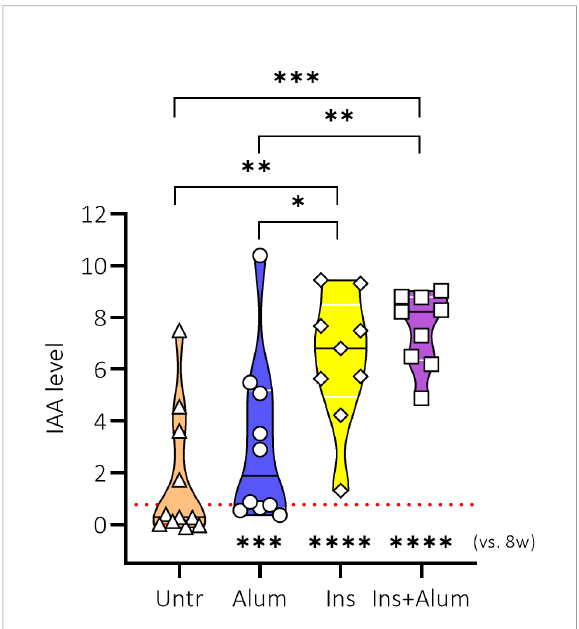
FIGURE 2 Effect of therapy on insulin autoantibody concentrations. IAA concentrations in plasma are shown at 15 weeks of age in female NOD mice receiving four weekly subcutaneous injections, from 10 until 13 weeks of age, of InsB:8-24 peptide formulated in alum (Ins+alum), InsB:8-24 peptide dissolved in buffer (Ins), alum alone (alum), or left untreated (Untr). The mean IAA value at 8 weeks of age (baseline) in all mice (n = 40) was 0.7627, represented by a dotted red line. Statistics underlying the violin plots represents comparison between baseline measurement at 8 weeks of age and the respective group at 15 weeks of age. Data presented as the median with interquartile range; symbols (n = 9-11) represent individual mice; arrows indicate islet in fi ltration. *P ≤ 0.05; **P ≤ 0.01; ***P ≤ 0.001; ****P ≤ 0.0001; NOD, non-obese diabetic; vs, versus; w,